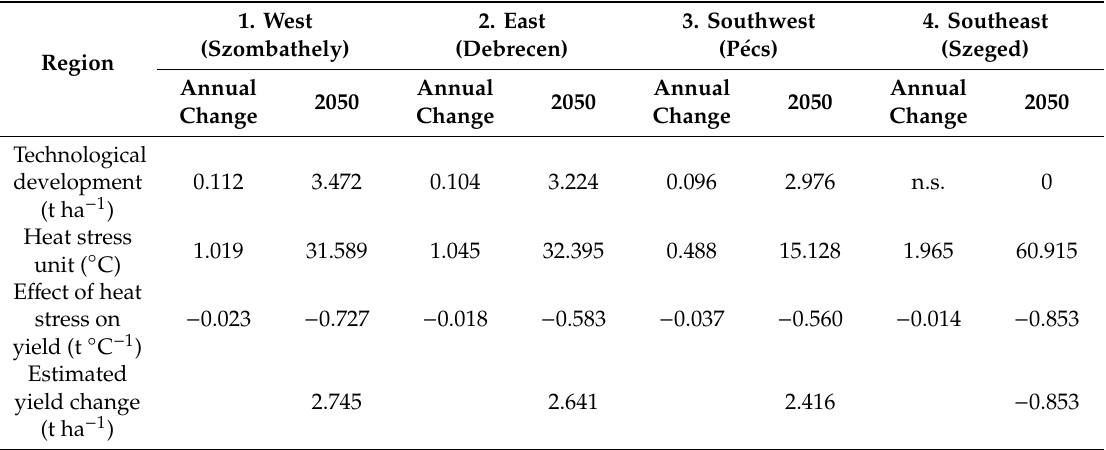
Table 5. E ff ect of technological development and heat stress on the average yield of maize